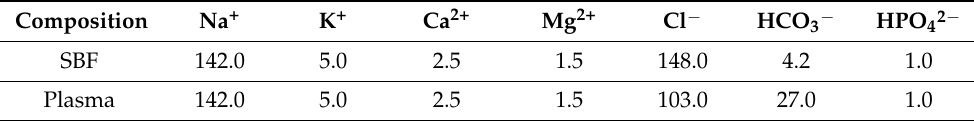
Table 1. Ionic concentration of the simulated body fluid (SBF) solution